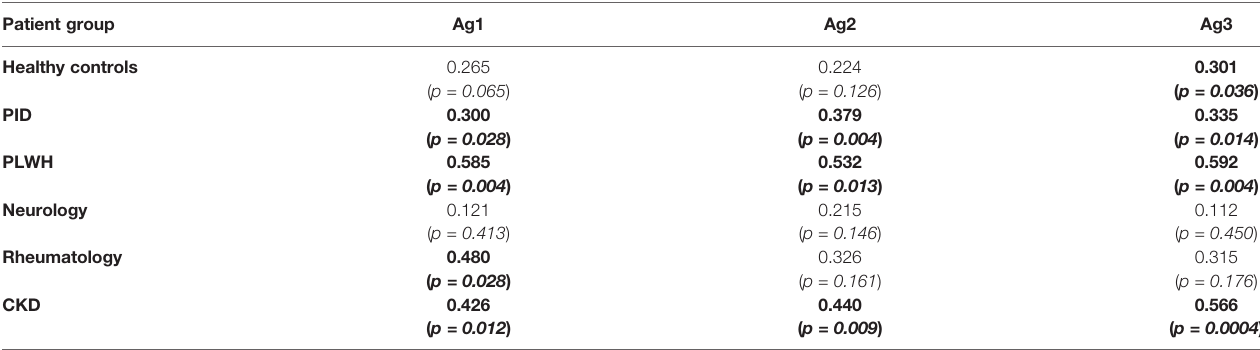
PID, primary immunode fi ciency; PLWH, patients living with HIV; CKD, Chronic kidney